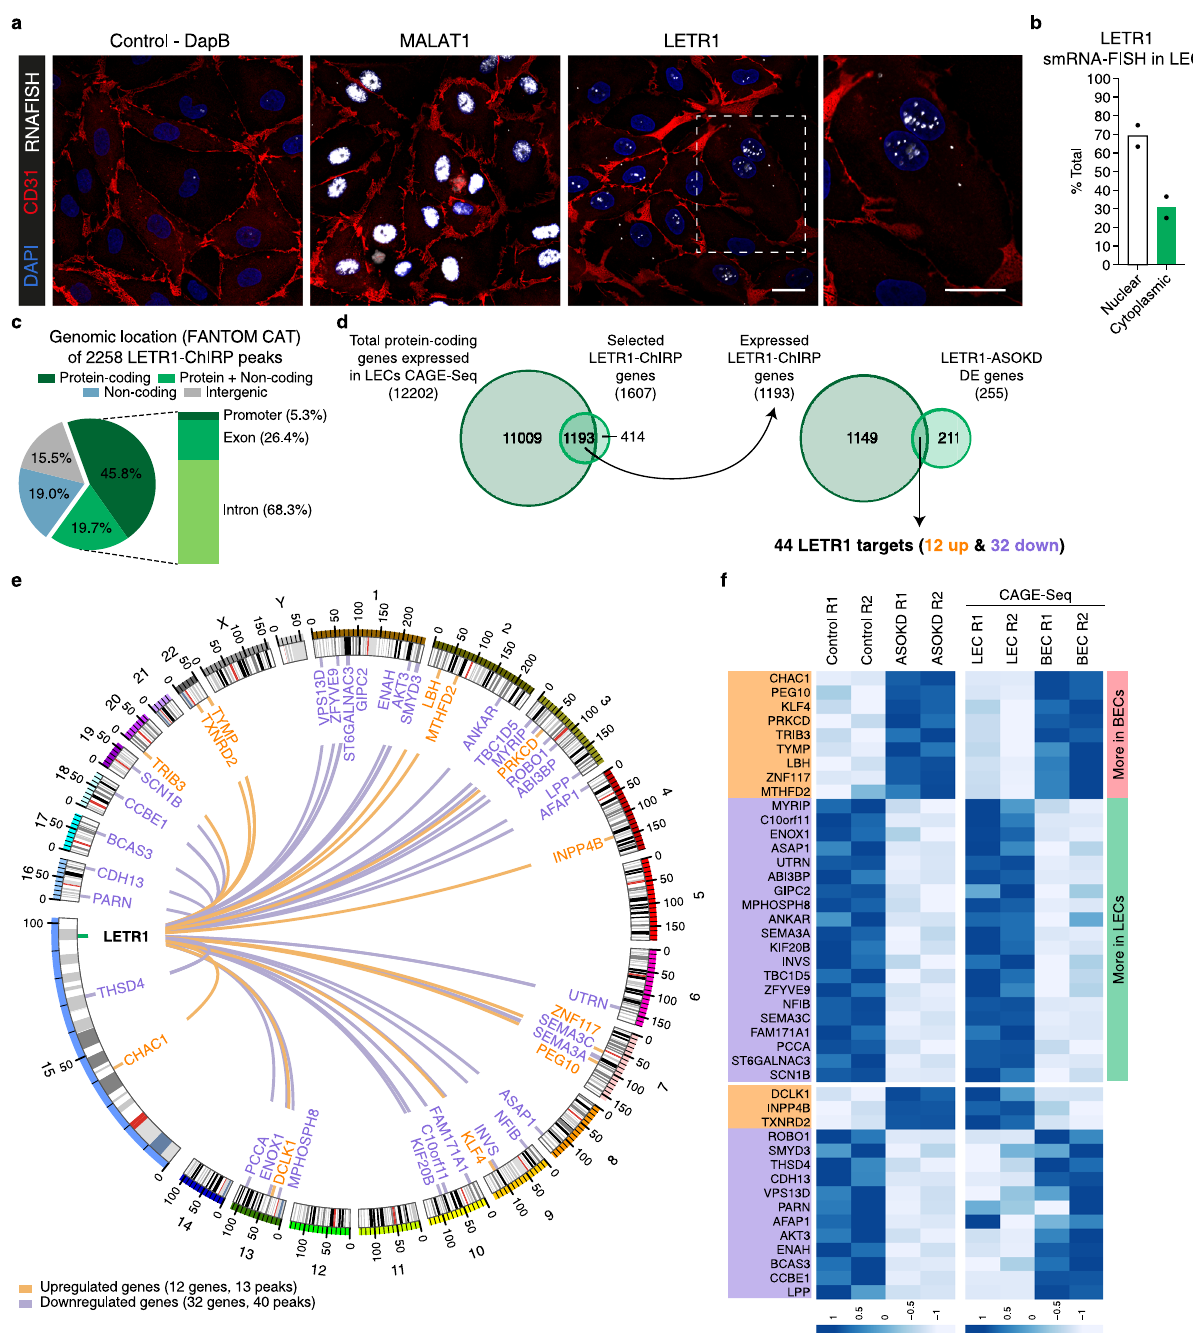
Fig. 6 LETR1 is a nuclear lncRNA interacting in trans with DNA regions near a subset of differentially expressed genes. a Representative images of negative control dapB (bacterial gene), MALAT-1 (nuclear lncRNA), and LETR1 expression using single-molecule RNA Fluorescence In Situ Hybridization (smRNA-FISH) in neonatal LECs derived from two donors. Immunostaining of endothelial cell marker CD31 was used to outline cell shape. Scale bars represent 20 µ m. b Quanti fi cation of the nuclear (green) and cytoplasmic (black) smRNA-FISH signal of LETR1 in neonatal LECs derived from two donors quanti fi ed with ImageJ 108 . Bars represent percentages displayed as mean values + SD ( n = 2). c Pie chart showing the genomic localization of the 2258 LETR1 peaks in protein-coding, overlap between protein-coding and noncoding, noncoding, and intergenic regions according to FANTOM CAT annotations using bedtools 116 . Magni fi cation shows the distribution of LETR1-binding sites within promoter, exon, or intron of protein-coding genes (1607 genes). LETR1 peaks are listed in Supplementary Data 10. d Venn diagrams showing the overlap between total genes expressed in LECs (TPM and CPM> 0.5) and identi fi ed LETR1-ChIRP genes, and the signi fi cant overlap between LETR1-ChIRP genes and differentially expressed genes after LETR1-ASOKD. e Circular plot showing genome-wide interactions of LETR1 near the 44 targets generated by Circos 117 . Scaled chromosomes with their respective cytobands are placed in circle. Major and minor ticks: 50 Mb and 10 Mb; orange and purple lines: interactions between LETR1 locus and its up- and downregulated targets; green line: genomic locus of LETR1. f Heat maps based on expression levels (CAGE-Seq, CPM) in scrambled control ASO and LETR1-ASOKD samples (left, two replicates), as well as in LECs and BECs (right, two replicates) of the 44 LETR1 targets (orange: upregulated; purple: downregulated). Color code for row Z score values on a scale from − 1 to + 1. Genes were ordered by log2FC values of ASOKD data and according to their differential expression between LECs and